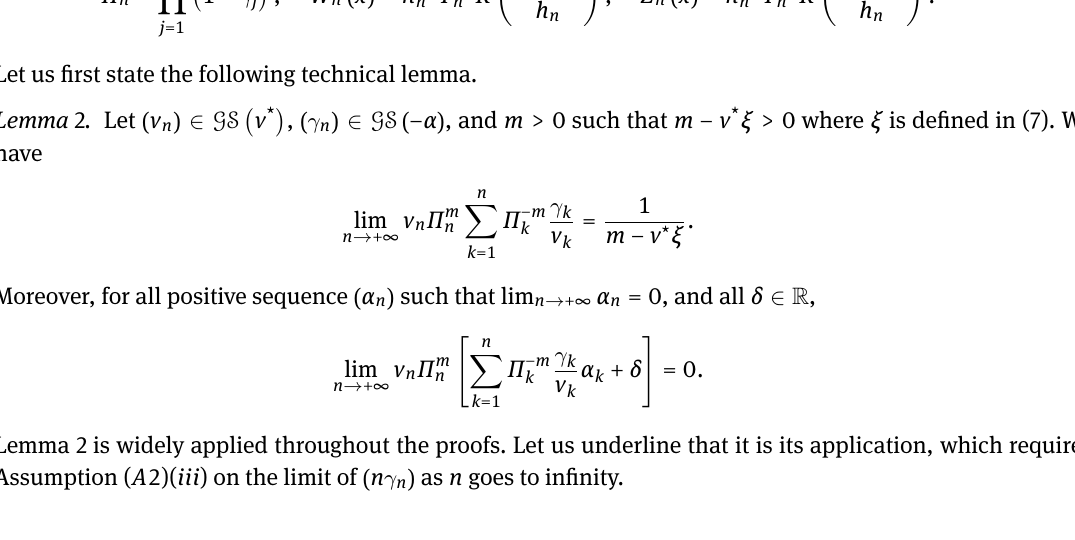
h k (cid:3)(cid:1) k =1